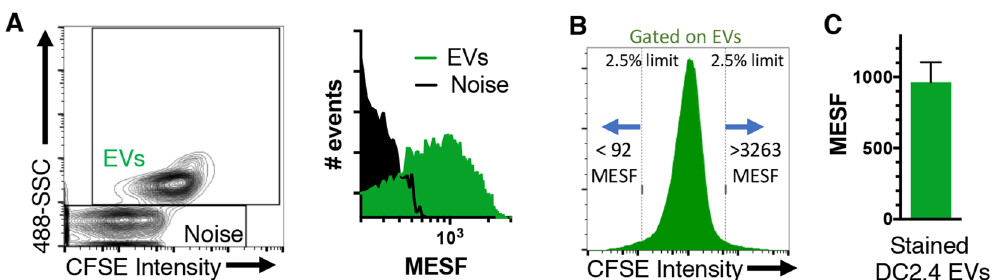
Figure 6. Fluorescence quantification of CFSE molecules on labeled EVs. ( A ) Background reference noise and EV fluorescence intensity transformed into a MESF histogram, see Supplementary Figure 6 for additional analysis. ( B ) Fluorescence detection range of the 95% of total EVs and ( C ) average MESF + SEM of EVs stained with CFSE, from four independent experiments. MESF, Molecules of Equivalent Soluble